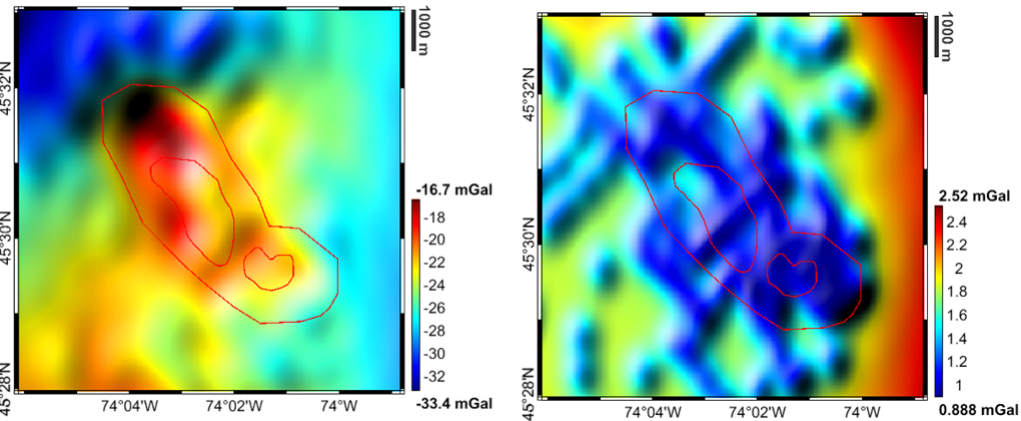
Figure 3. Computed grid of Bouguer gravity anomalies ( left ) and predicted accuracy ( right ). Red lines represents the boundaries of main units of the Oka complex.